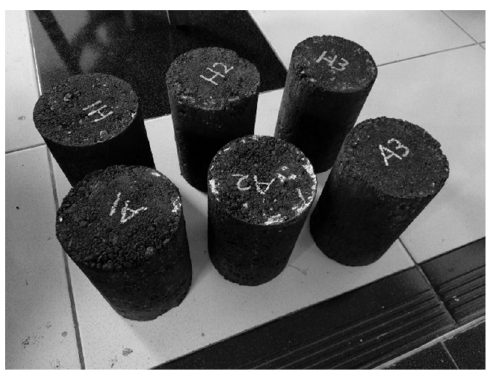
Figure 3. Specimens for dynamic modulus test.